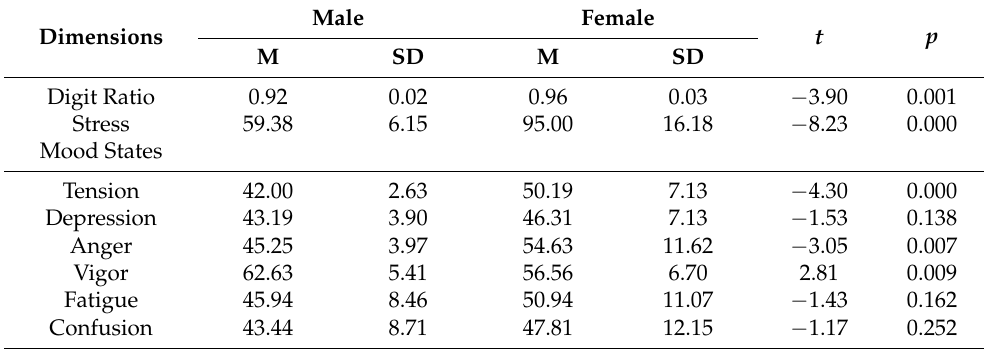
Table 2. Gender differences in the dimensions of the study. (Student’s t -test, p < 0.05).